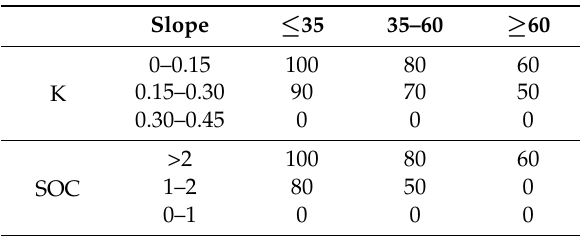
Table 6. Biomass available (%) in different conditions of slope (%), soil erodibility factor (K, Mg ha h ha − 1 MJ − 1 mm − 1 ) and soil organic carbon SOC